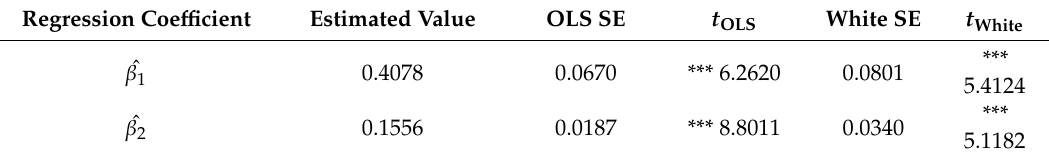
Table 5. Estimated results of coe ffi cients for control